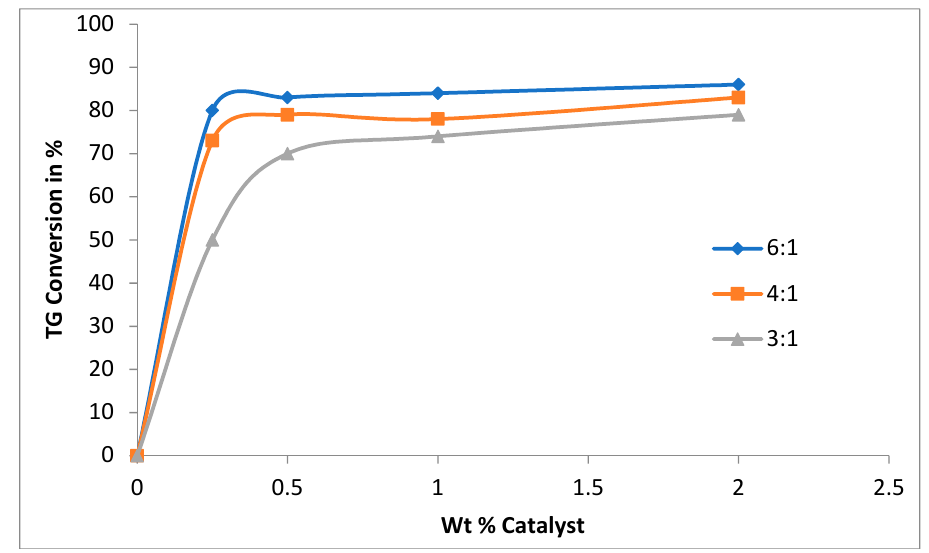
Figure 1. Effect of catalyst concentration on triglyceride conversion in a batch reactor. 0.5 wt % catalyst (CH 3 ONa), methanol:oil ratio (6:1, 4:1, 3:1), ultrasound amplitude 60%, temperature 35 °C, reaction time 1 min.